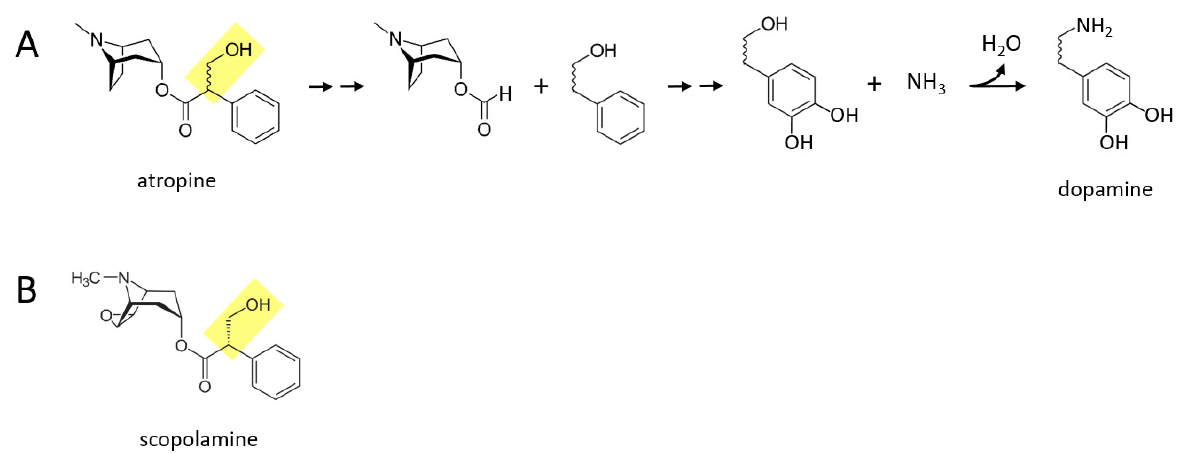
Figure 4. Certain alkaloid drugs found in nightshade plants may also be acutely converted to catecholamines in the body. ( A ) Atropine could be converted to dopamine in a series of proposed reactions. Double arrows indicate two or more reactions. ( B ) Scopolamine, like atropine, contains a moiety (shown in yellow) that may facilitate enzymatic conversion to